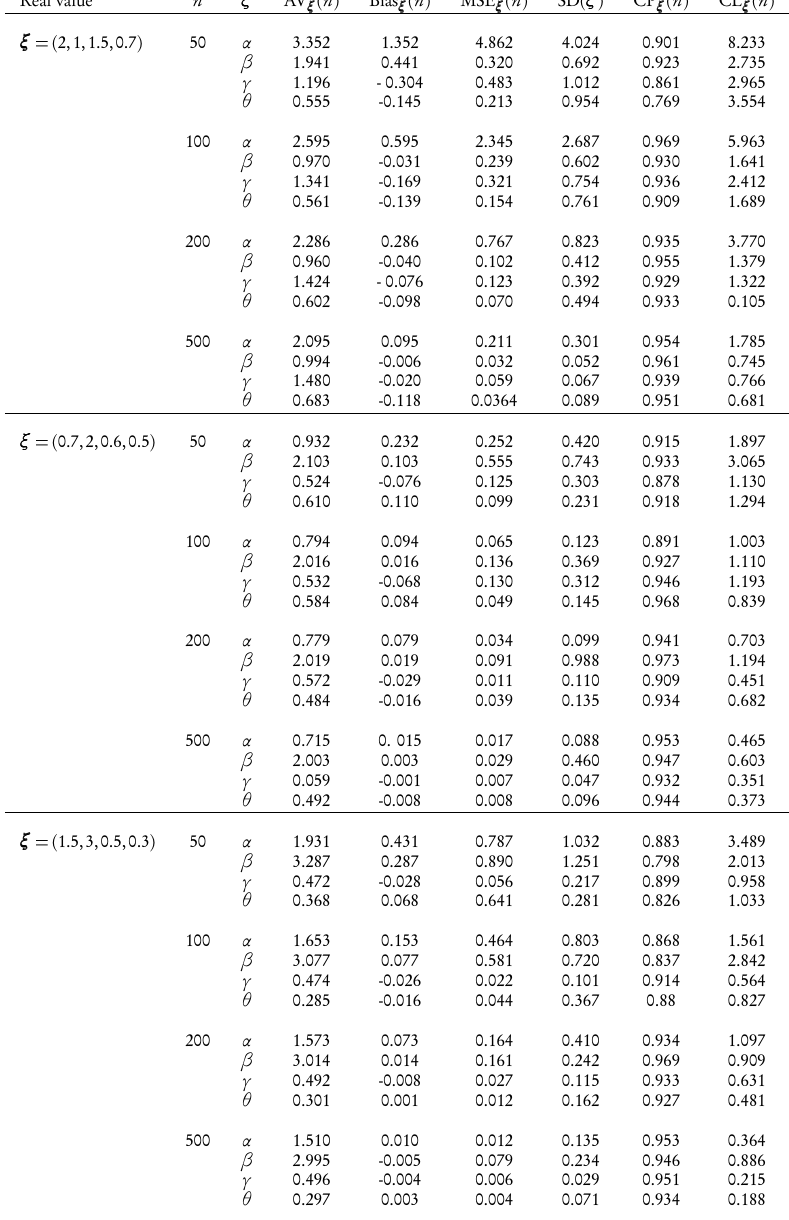
The mean, bias, MSE, standard error, CP and CL of the MLE estimators from 10000 samples. Real value